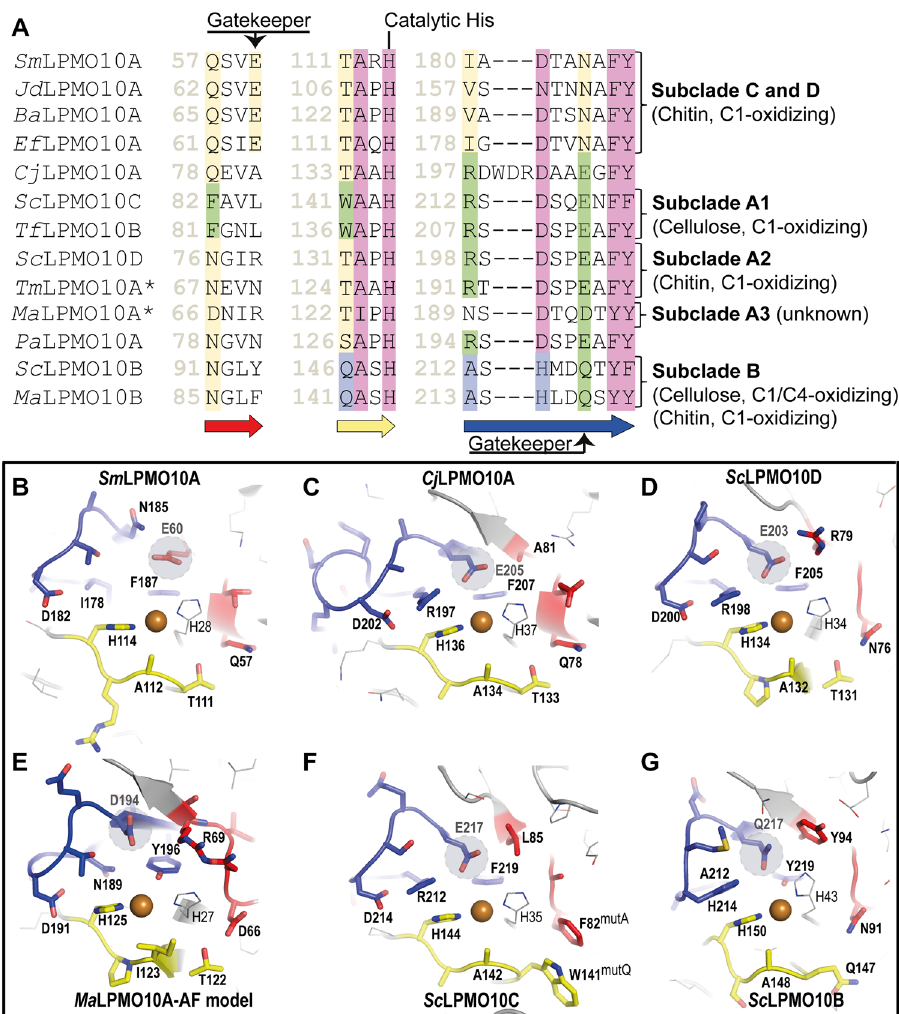
Figure 4. Structural comparison of active site residues in Sc LPMO10D and LPMOs from different subclades in the AA10 phylogenetic tree. ( A ) Show sections of a structural sequence alignment of 13 selected LPMO10s covering the subclades that were defined in the study by Book et al. 31 and includes seven chitin-oxidizing LPMO10s, Sm LPMO10A (PDB ID: 2BEM; also known as CBP21), Jd LPMO10A (PDB ID: 5AA7), Ba LPMO10A (PDB ID: 2YOY), Ef LPMO10A (PDB ID: 4ALC), Cj LPMO10A (PDB ID: 5FJQ), Sc LPMO10D (PDB ID: 7ZJB) and Pa LPMO10A (also known as CbpD, PDB ID: 7SQX), and four cellulose-active LPMO10s, namely Sc LPMO10C (PDB ID: 4OY7; also known as CelS2), Tf LPMO10B (also known as E8; no crystal structure available), Sc LPMO10B (PDB ID: 4OY6) and Ma LPMO10B (PDB ID: 5OPF). The green- and yellow-colored amino acids indicate similarity to typical cellulose-active and typical chitin-active LPMOs, respectively. Blue colored amino acids are specific for subclade B LPMO10s, which have mixed regioselectivity and substrate specificity and whose active site resembles the typical active sites of fungal AA9 LPMOs. Purple residues indicate fully or highly conserved residues, including one of the catalytic histidines. Asterisks indicates that activity has not been reported. Note that the structurally conserved ‘gatekeeper’ residue, which is a Glu in LPMOs from Subclade C and D, has different positions in the LPMO sequence, depending on the subclade, as indicated above and under the alignment. The arrows under the alignment are labelled according to colors used in ( B – G ), showing the active sites of Sm LPMO10A ( B ), Cj LPMO10A ( C ), Sc LPMO10D ( D ), Ma LPMO10A ( E ), Sc LPMO10C ( F ) and Sc LPMO10B ( G ). Note that the structure of Ma LPMO10A was not determined experimentally but predicted using AlphaFold 48